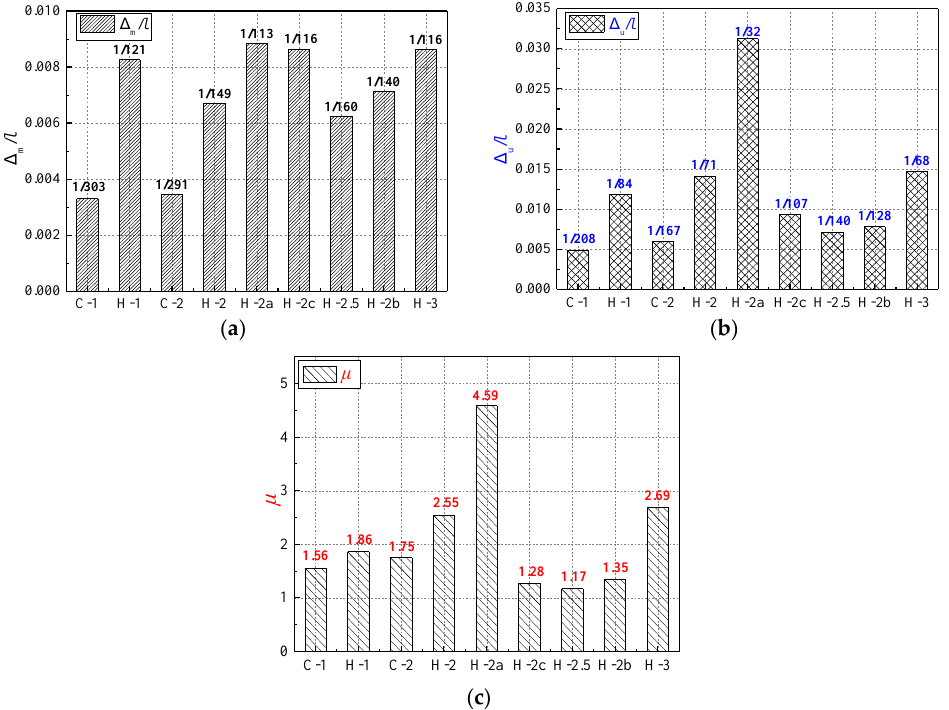
Figure 5. Displacement factors. ( a ) Deflection-clear span ratio corresponding to the peak load; ( b ) Deflection-clear span ratio corresponding to the ultimate deflection; ( c ) Displacement ductility factor.